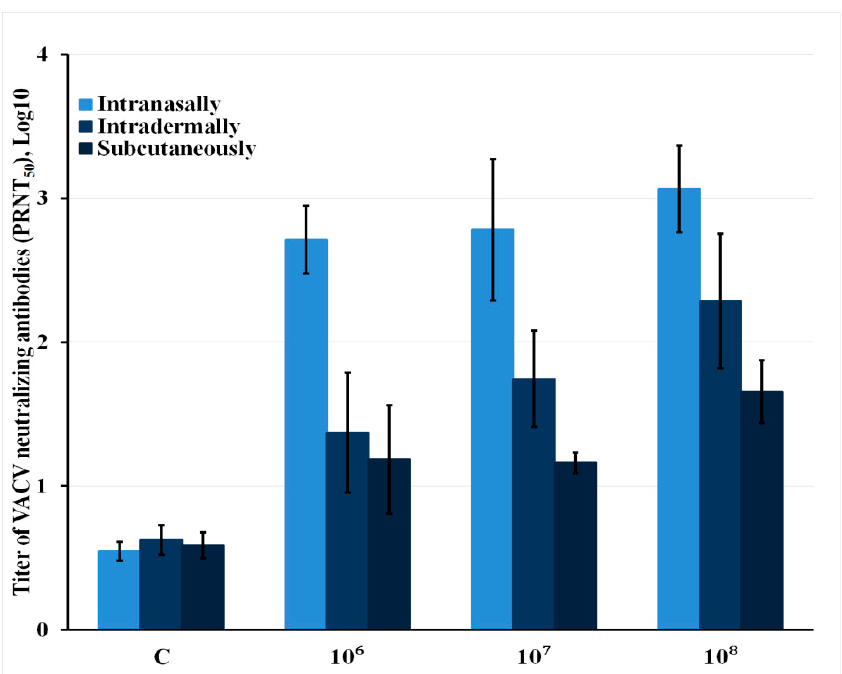
Figure 5. The data on VACV-neutralizing activity of serum samples collected on day 28 after the mice had been infected with different doses (10 6 , 10 7 , and 10 8 pfu) of the LIVP-14 strain via different routes. C (control)—serum samples from mice that received saline solution. The error bars indicate 95% lower and upper limits of the estimated titer. Each group consisted of six animals.